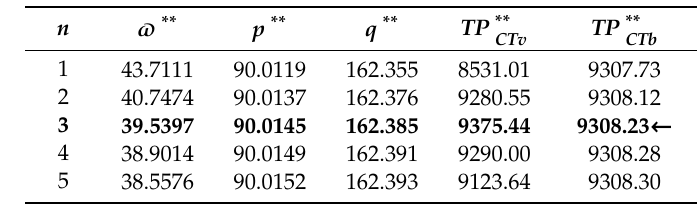
Table 2. Solution procedure of Example